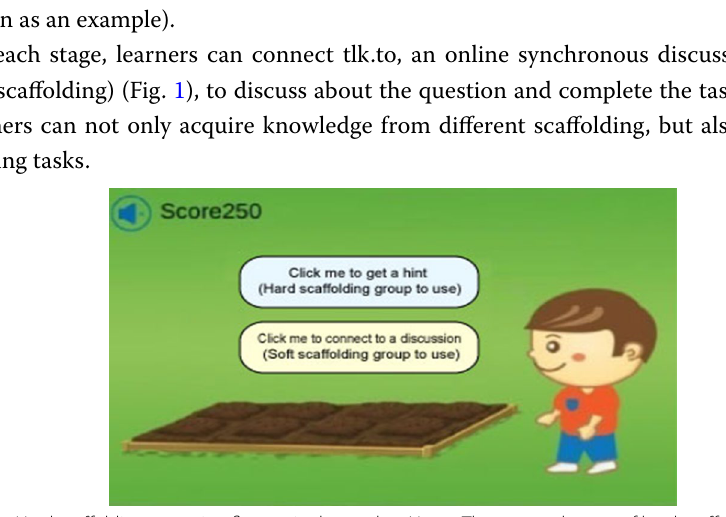
Fig. 1 Hard scaffolding‑ watering flowers in the garden. Notes: The prompt button of hard scaffolding will only be displayed for the hard scaffolding DGBL; the prompt button of soft scaffolding will only be displayed for the soft scaffolding DGBL